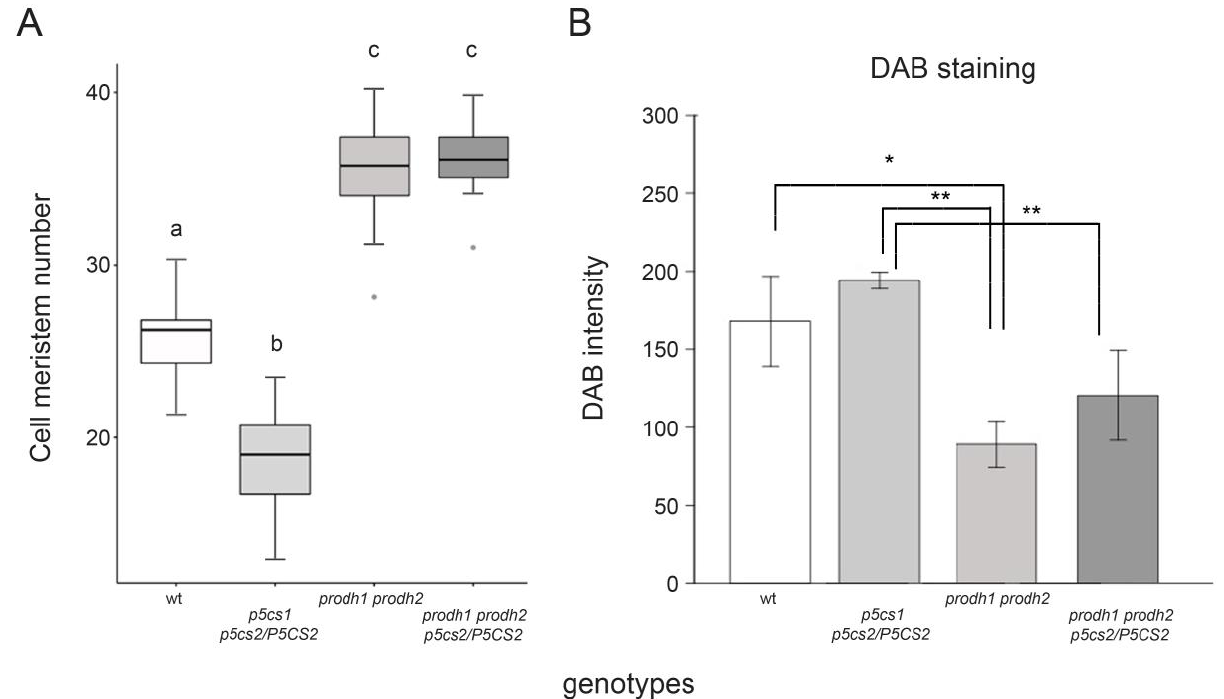
Figure 7. Arabidopsis mutants impaired in proline catabolism have large root meristems. ( A ) Boxplot representation of the average number of meristem cells in roots from wildtype, p5cs1 p5cs2/P5CS2 , prodh1 prodh2 , and prodh1 prodh2 p5cs1 p5cs2/P5CS2 plants. Significance among groups was estimated by One-Way ANOVA, followed by a Tukey post-hoc test, which found statistically significant differ- ences among groups a, b, and c ( p < 0.001). ( B ) DAB staining in wildtype, p5cs1 p5cs2/P5CS2 , prodh1 prodh2, and prodh1 prodh2 p5cs1 p5cs2/P5CS2 roots. Because variance among groups was not homoge- neous, we performed a Welch t -test analysis with Bonferroni correction for multiple testing finding significant differences among genotypes (* p < 0.05 between prodh1 prodh2 and wildtype; ** p < 0.01 between prodh1 prodh2 and p5cs1 p5cs2/P5CS2 , and between and prodh1 prodh2 p5cs1 p5cs2/P5CS2 and p5cs1 p5cs2/P5CS2 ). Each mean derives from the means of at least three independent experiments, each one replicated three times and comprising ten